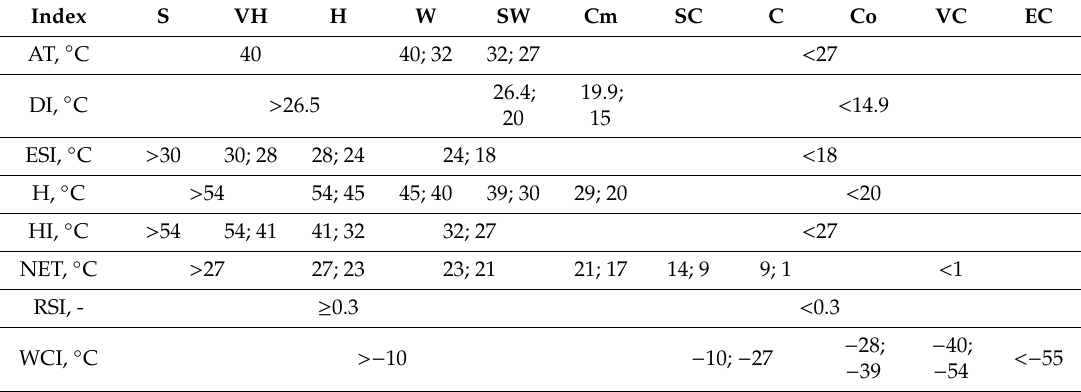
Table 4. Thermal sensation scales of the outdoor comfort indexes: R = Reference, S = Sweltering, VH = Very Hot, H = Hot, W = Warm, SW = Slightly Warm, Cm = Comfortable, SC = Slightly Cool, C = Cool, Co = Cold, VC = Very Cold and EC = Extremely